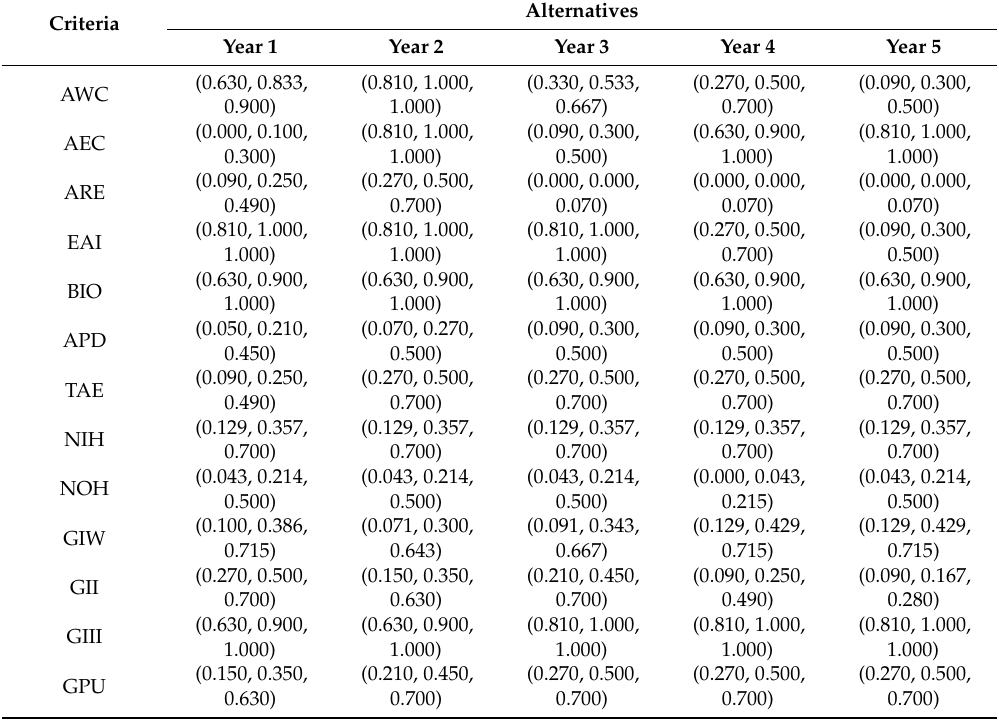
Table 5. The fuzzy weighted normalised decision matrix obtained from the expert’s judgements. Criteria